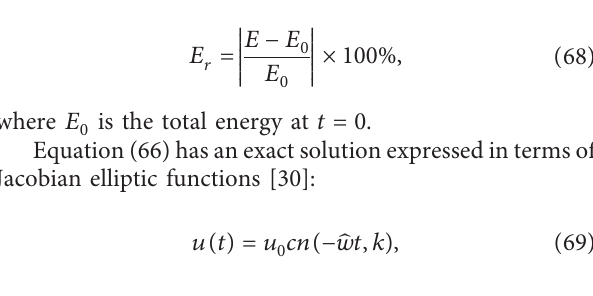
Figure 8: Convergence rate of CQ-2 x assessed in terms of the average relative displacement error.